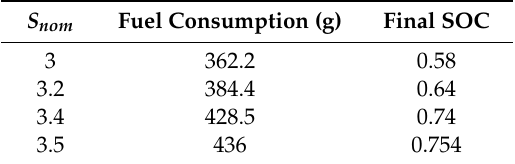
Figure 2. State of Charge (SOC) evaluations for di ff erent s nom under the Urban Dynamometer Driving Schedule (UDDS) cycle. Table 2. Fuel Consumption and Final SOC for Di ff erent s nom under